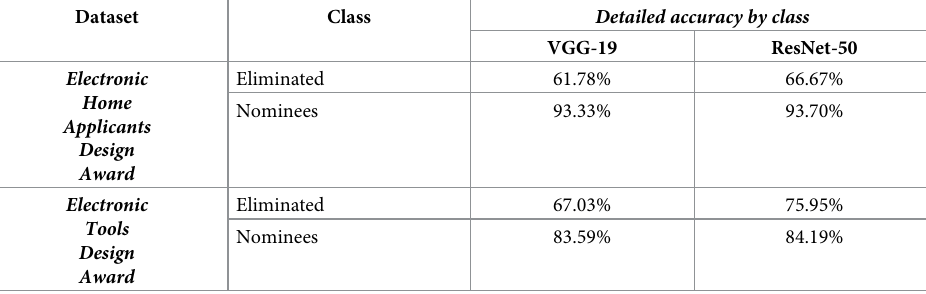
Table 8. Aesthetic-aware classification accuracy comparison using VGG-19 and ResNet-50.